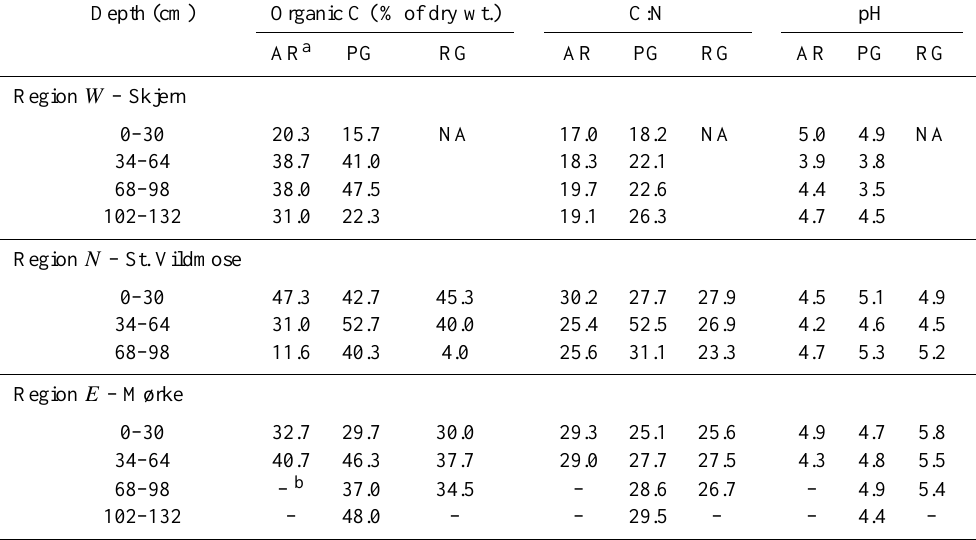
Table 3. Soil organic carbon, C:N ratio and pH of the peat in the eight organic soils used in the monitoring study. Rotational grass (RG) was not represented in region W. AR – arable crop; PG – permanent grassland; RG – rotational grass.